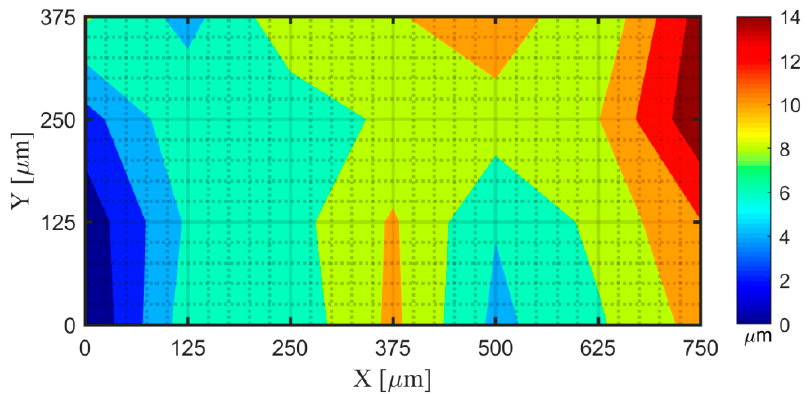
Figure 20. Contour of the Euclidean residuals between each certified and measured points.